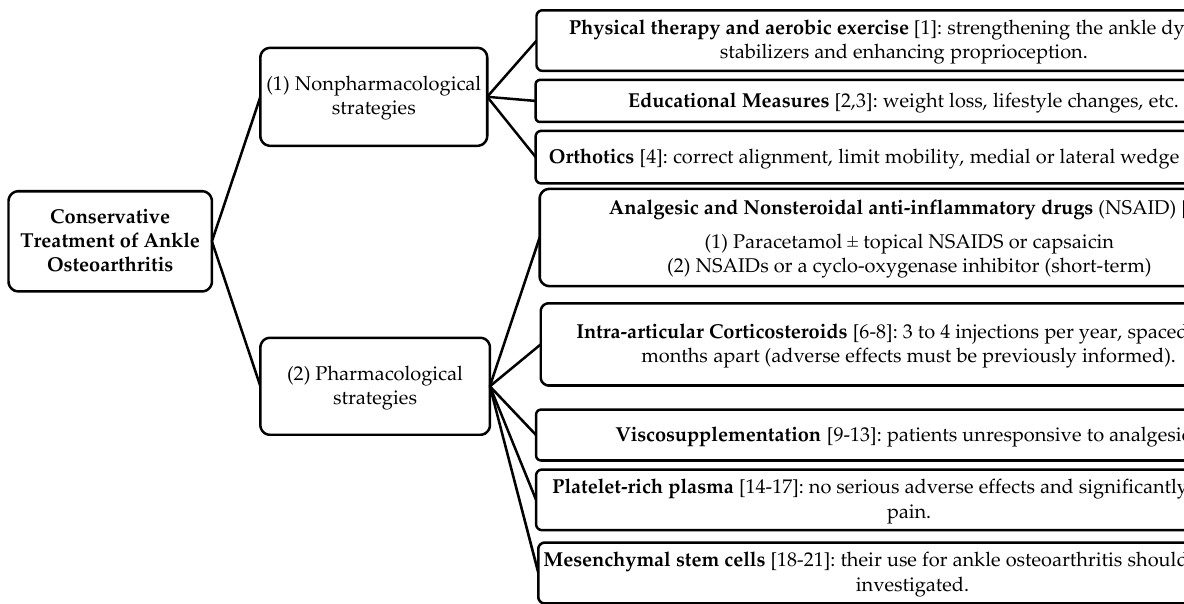
Figure 1. Conservative Treatment of Ankle Osteoarthritis: non-pharmacological (first step) and pharmacological (second step) strategies.